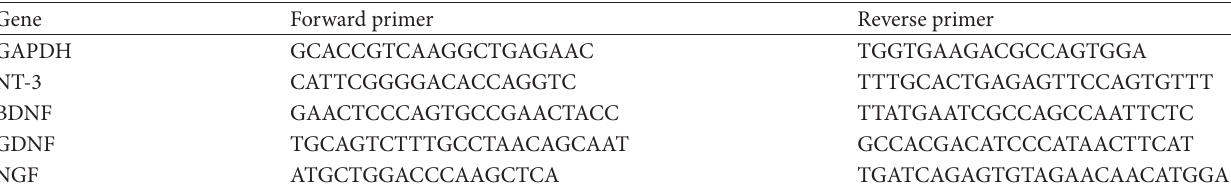
Table 1: Primers used for real-time polymerase chain